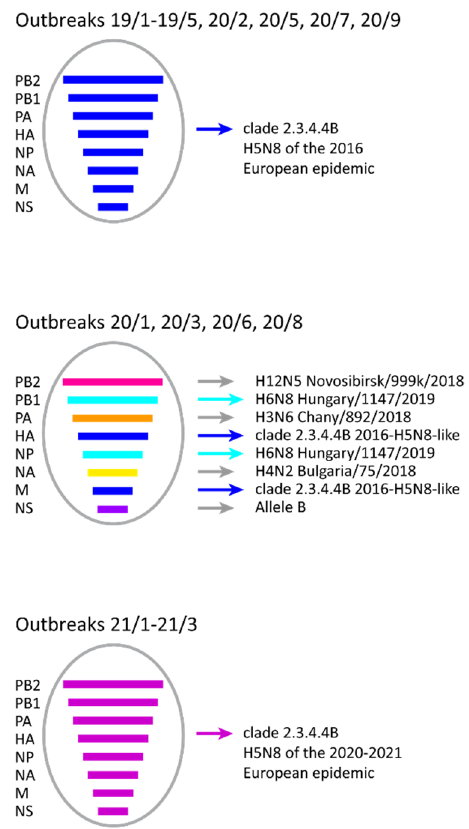
Figure 2. HPAI A(H5) genotypes identified in Bulgaria in 2019–2021. Blue bars: gene segments originating from Eurasian/African HPAI H5N8 viruses of the European epidemic started in 2016; violet bars: gene segments originating from Eurasian/African HPAI H5N8 viruses of the European epidemic of 2020–2021; pink bar: gene segment closely related to the LPAI virus A/mallard/Novosibirsk region/999k/2018; light-blue bars: gene segments closely related to the LPAI virus A/duck/Hungary/1147/2019; orange bar: gene segment closely related to the LPAI virus A/common teal/Chany/892/2018; yellow bar: gene segment closely related to the LPAI virus A/duck/Bulgaria_Plovdiv/75/2018 ; dark violet bar: gene segment closely related to viruses of which the NS gene belongs to Allele B.